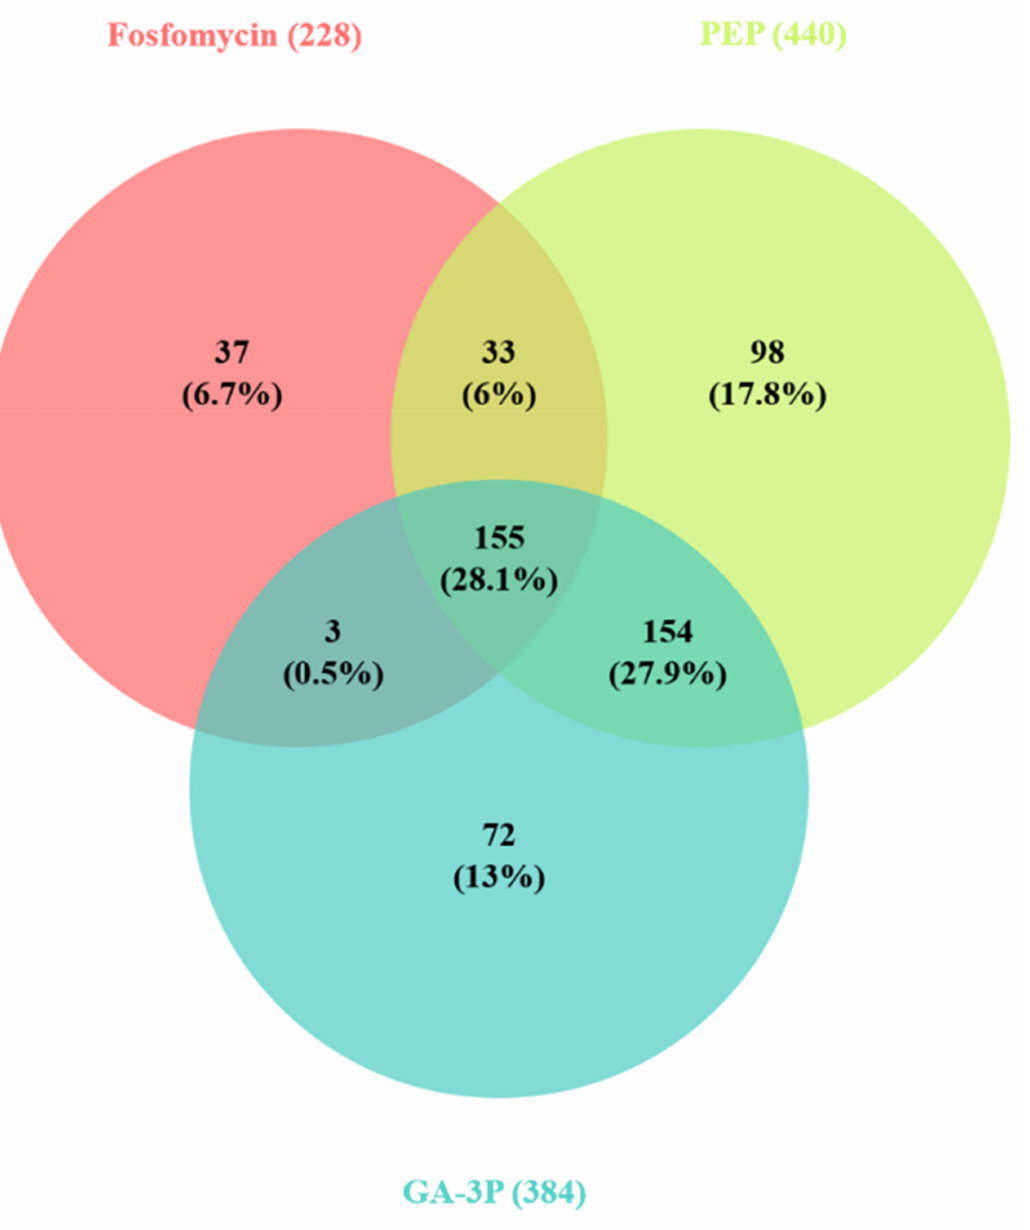
Figure 2. Common and differential transcriptomic changes after S. maltophilia treatments. Venn diagram showing the number of genes whose expression changed (>1 log 2 fold or < − 1 log 2 fold) after the treatments. As shown, most transcriptomic changes were common between the